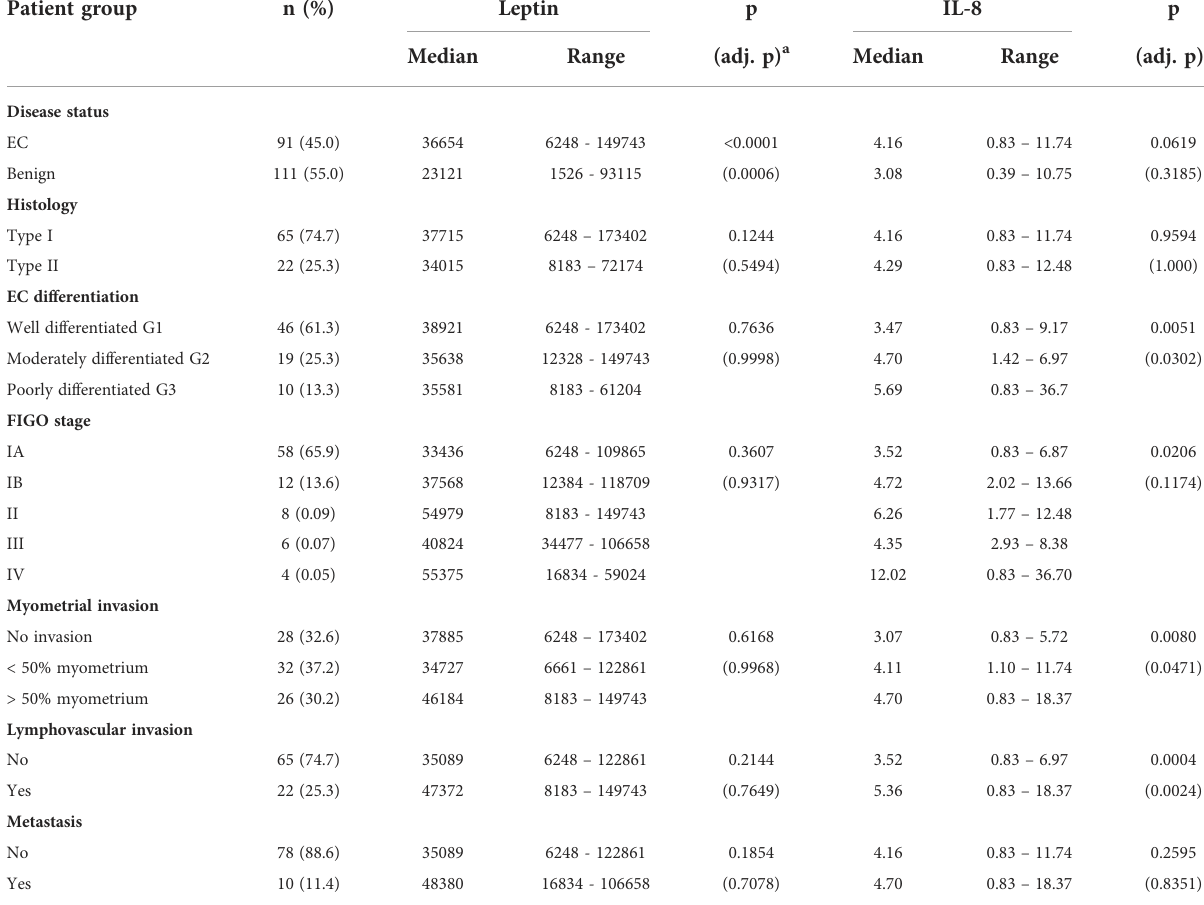
TABLE 2 Plasma leptin and IL-8 levels in patients with endometrial cancer and control patients. Patient